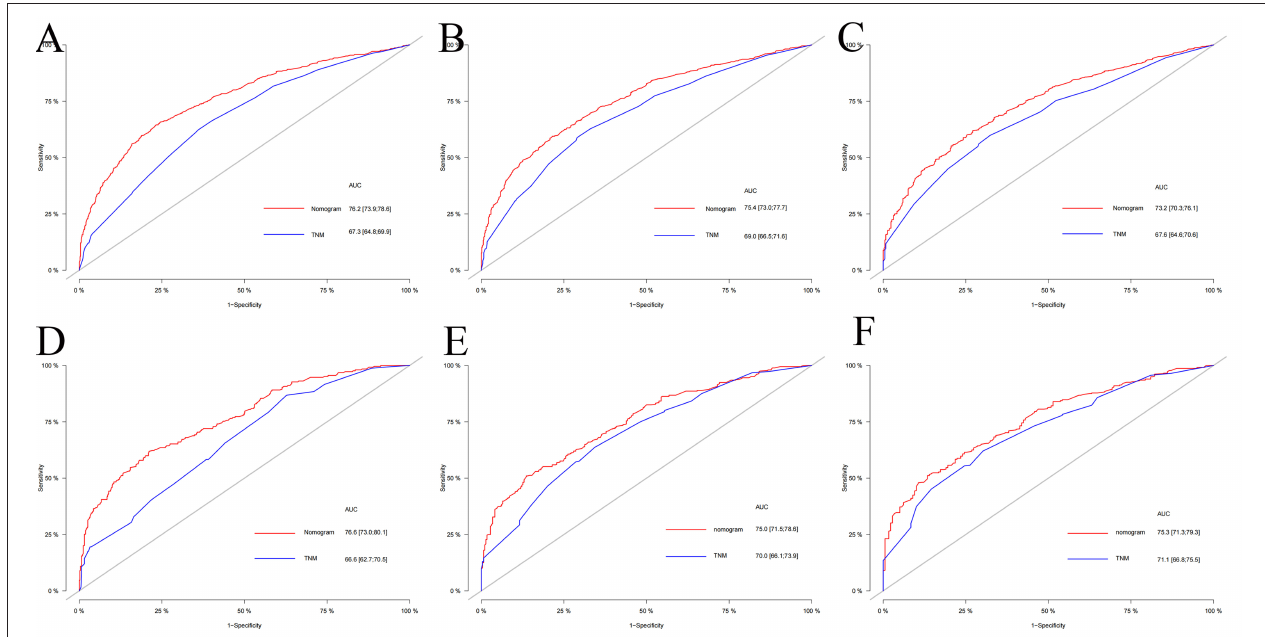
FIGURE 4 | The AUC of nomogram and TNM stage of 1-, 3- and 5-year in the training set (A–C) and validation set (D–F) .